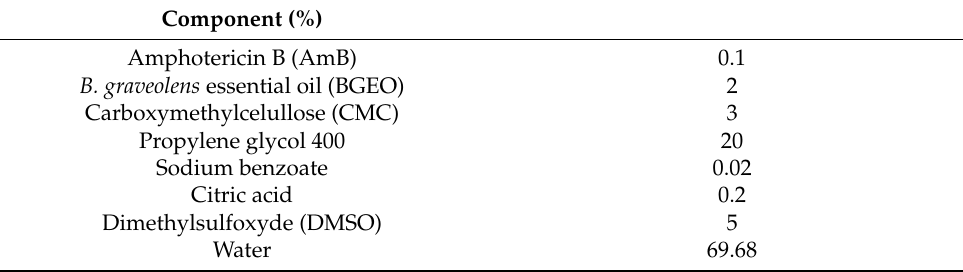
Table 2. Final formulation of AmB+BGEO gel.